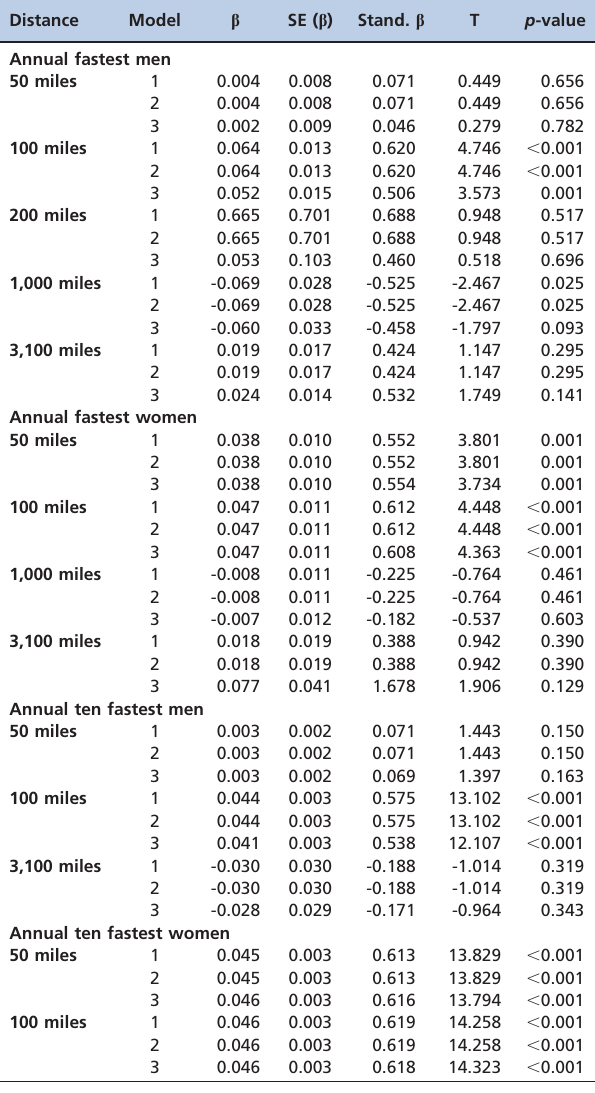
Table 2 - Multi-level regression analyses for change in running speed over time (Model 1) with correction for multiple finishes (Model 2) and with correction for multiple finishes and age of competitors with multiple finishes (Model 3) for the annual fastest and annual ten fastest women and